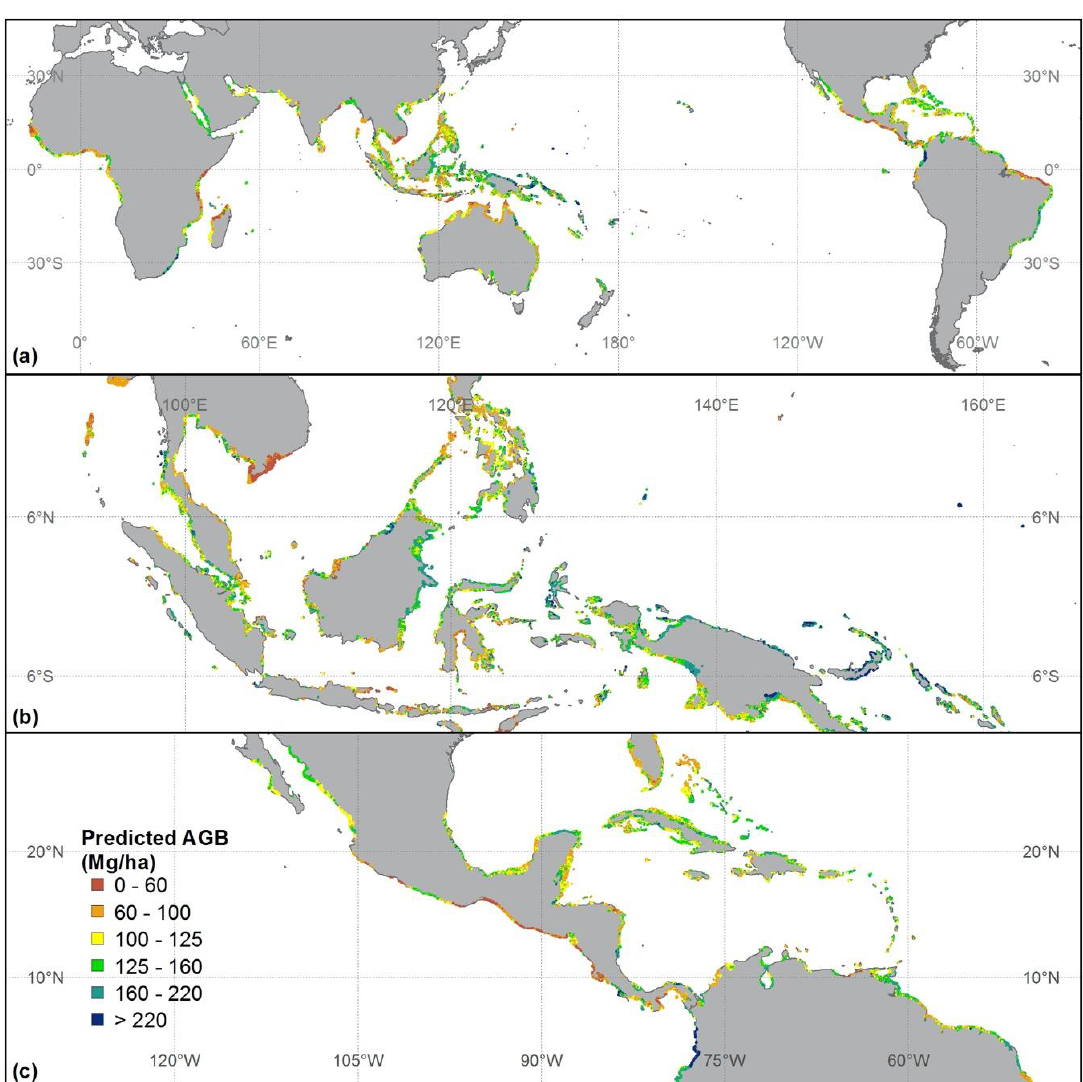
Figure 4. Predicted mangrove forest AGB distribution ( a ) throughout the world, ( b ) enlarged over Southeastern Asia, and ( c ) enlarged over Central America.